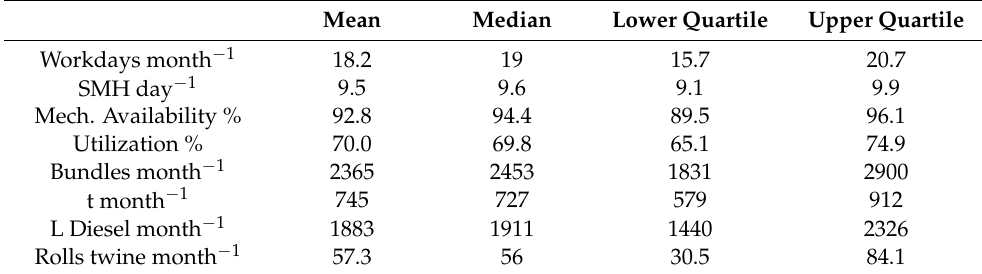
Table 1. Monthly use statistics ( n = 94). Mean